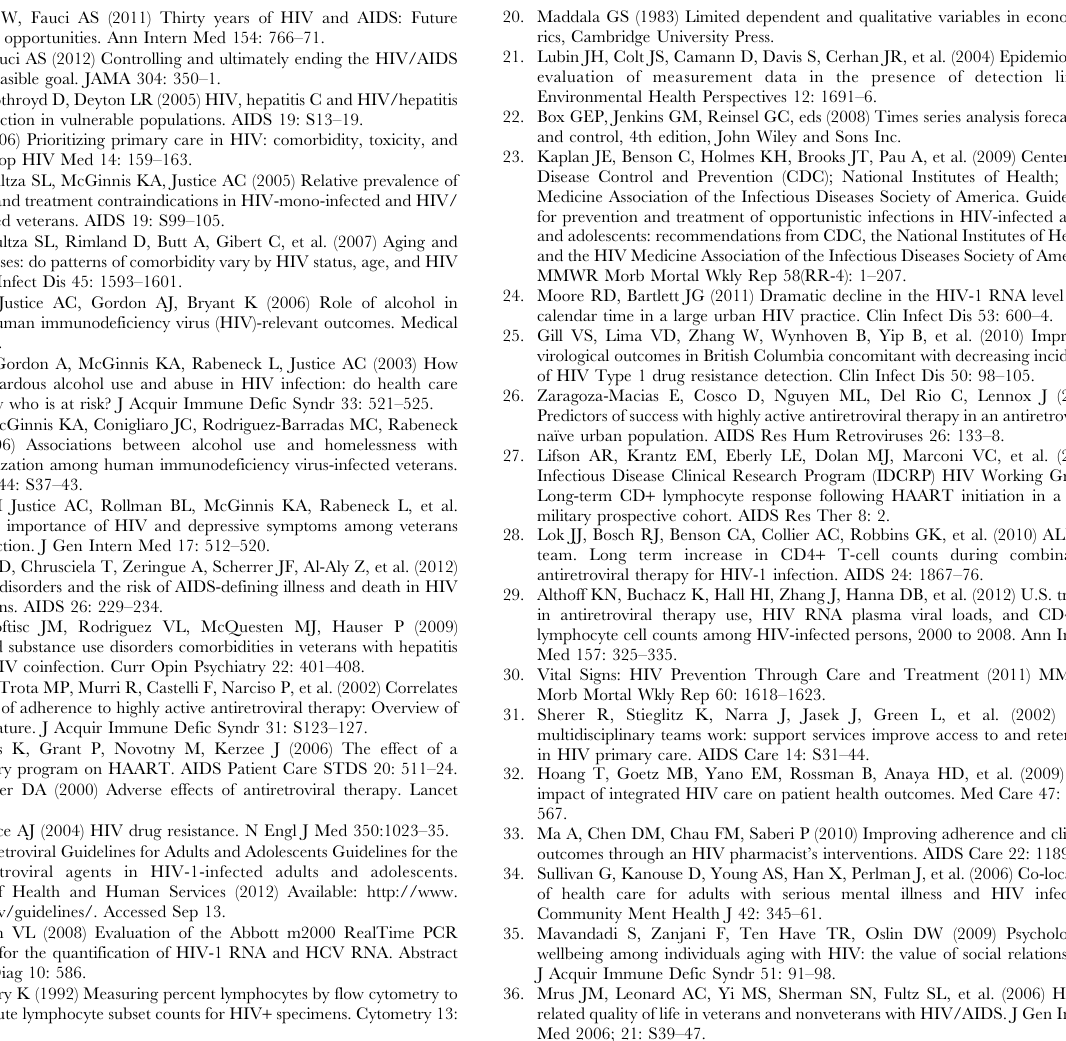
Table S2 Distribution of the final CD4 cell counts for individual patients by calendar